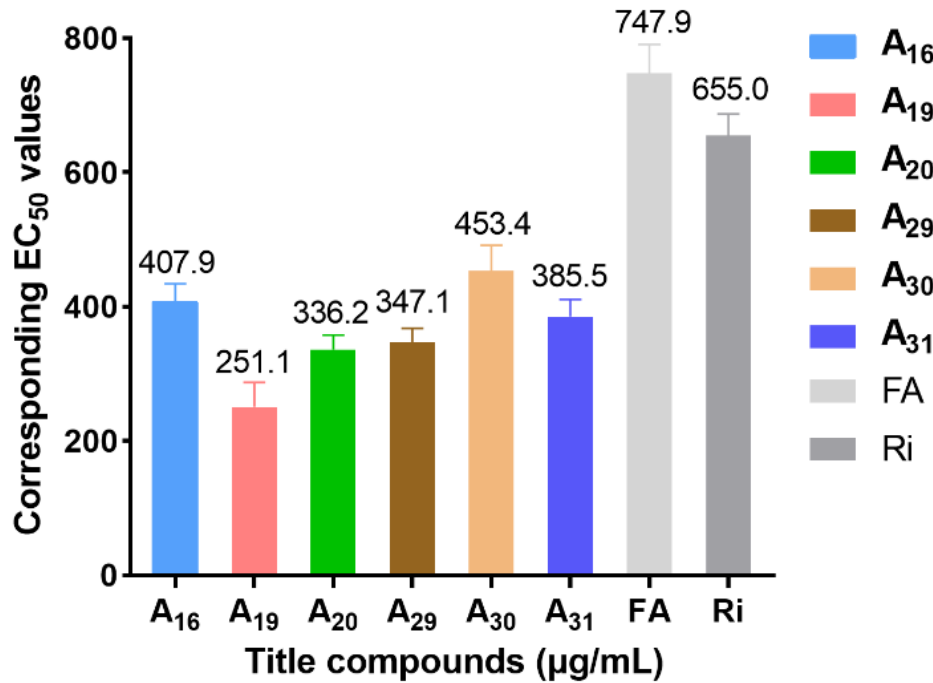
Figure 4. The EC 50 values of curative activities of target compounds and Ri against TMV in vivo. Since these compounds all have a unique chiral center, the differences in configura ‐ tion may also often affect molecule biological activity in the host. As a result, to investigate the influence of absolute configuration of title molecules on overall antiviral activity or target receptor bioactivity, different antiviral levels of derivatives R ‐ A 16 , S ‐ A 16 , R ‐ A 19 , S ‐ A 19 , R ‐ A 20 , S ‐ A 20 , R ‐ A 29 , and S ‐ A 29 were synthesized (Figure 5). Their antiviral curative activities (Table 3) presented the following order: S ‐ forms (45.7%, S ‐ A 16 ) < S ‐ forms (49.9%, S ‐ A 20 ) < R ‐ forms (55.1%, R ‐ A 16 ) ≈ S ‐ forms (55.4%, S ‐ A 19 ) < R ‐ forms (58.0%, R ‐ A 20 ) < R ‐ forms (67.5%, R ‐ A 19 ) at 500 μ g/mL, suggesting that the R ‐ forms of target compounds were more beneficial to aggrandize antiviral activity (Figure 6). Table 3. The in vivo anti ‐ TMV activity of R ‐ A 16 to S ‐ A 29 . Compound